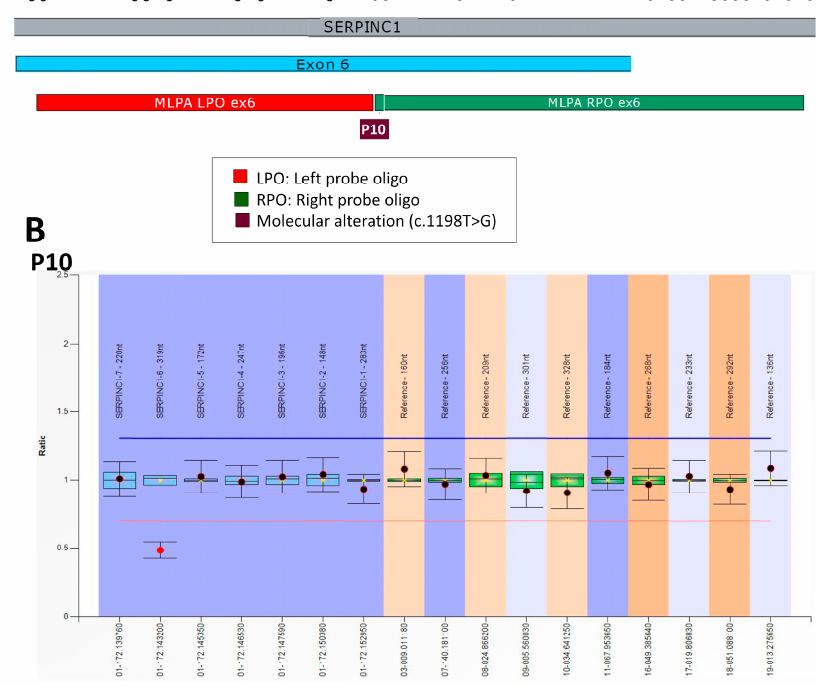
Figure 6. Genetic defect identified in patient P10: ( A ) localization of SNV and MLPA probes in the structure of exon 6 of SERPINC1 (blue); ( B ) MLPA result obtained in P10 that incorrectly recognized a heterozygous deletion of exon 6.